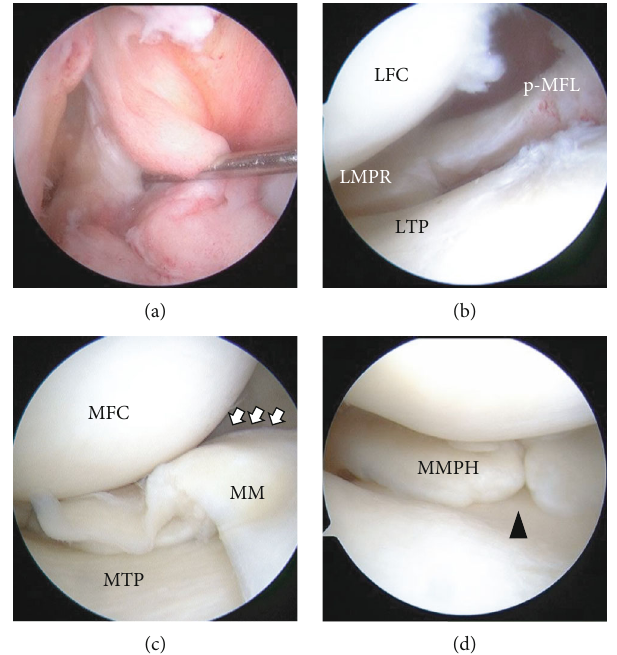
Figure 1: (a – d) Arthroscopic fi ndings. (a) Chronic ACL tear. (b) The torn edge of the LMPR was defected. (c) Reduced MM bucket handle tear (white arrows) extending from the body to the posterior horn. (d) Complete radial tear of the posterior horn of the MM (black arrowhead). Abbreviations: LTP: lateral tibial plateau; LFC: lateral femoral condyle; p-MFL: posterior meniscofemoral ligament (Wrisberg ligament); MTP: medial tibial plateau; MFC: medial femoral condyle; MMPH: medial meniscus posterior